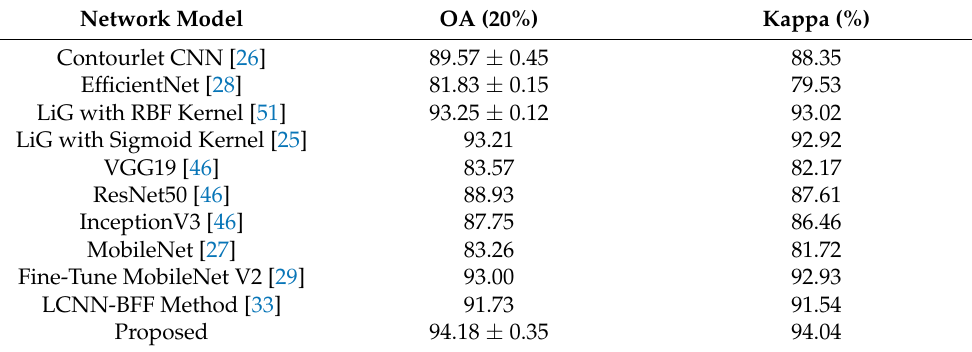
Table 10. Kappa (%) of ten methods and the LCNN-CMGF method at the training ratio of 20% in the NWPU45